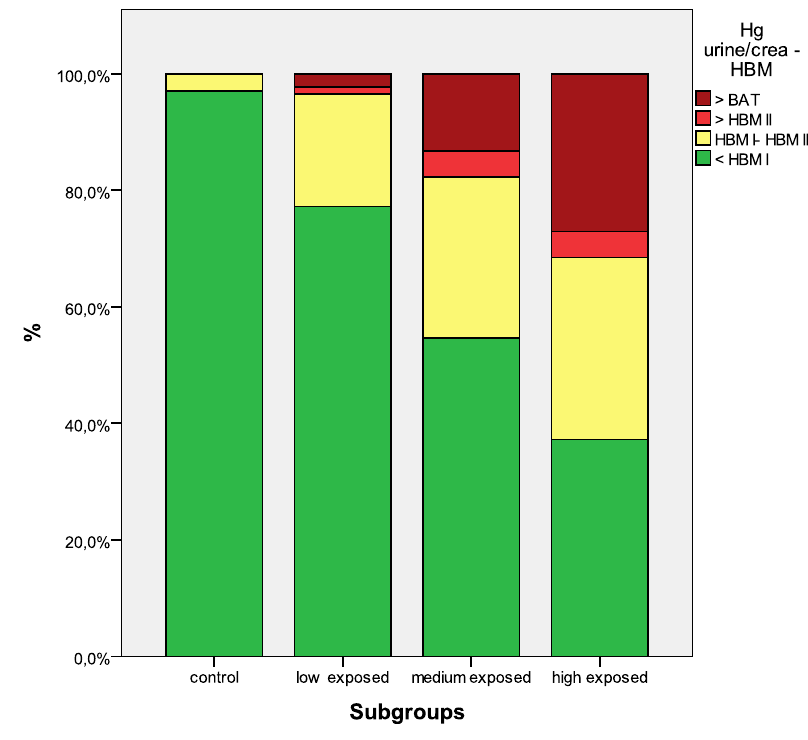
Figure 6. Mercury in urine/g crea—stacked bar chart for threshold values.